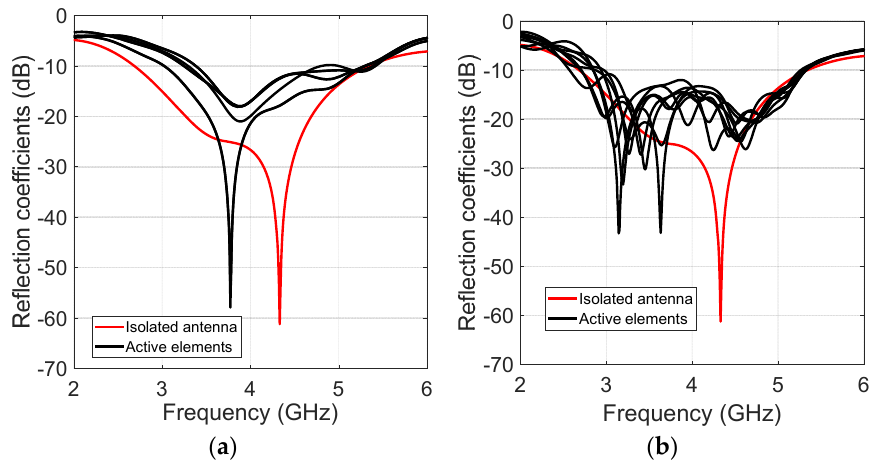
Figure 3. Reflection coefficients: ( a ) uniform spacing λ /2; ( b ) non ‐ uniform array.